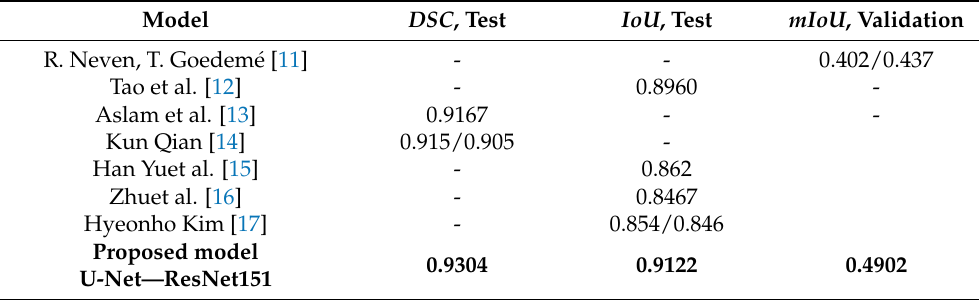
Table 3. Test metrics of the developed model as compared to metrics of similar models for surface damage